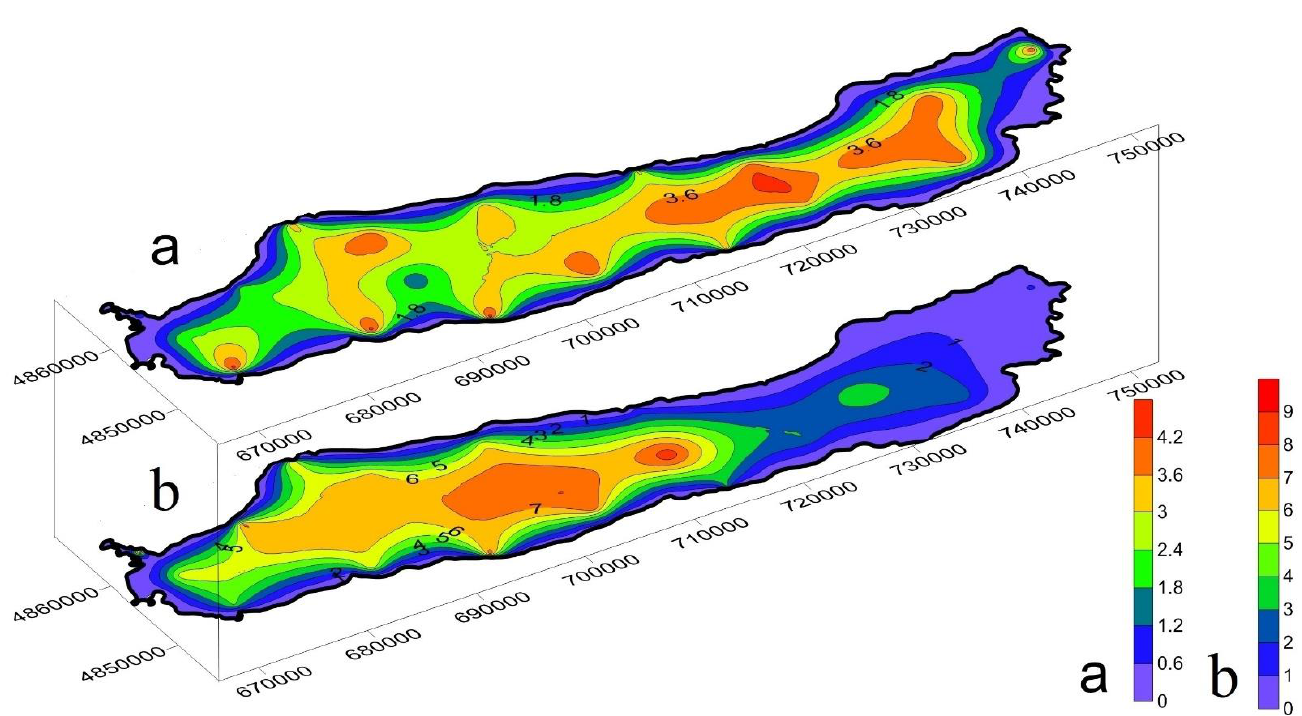
Figure 5. Spatial distribution of lead in water and bottom sediment of the Kapshagay Reservoir. ( a ) Water — µg/L; ( b ) bottom sediment — mg/kg. (authors Ismukhanova L.T., Madibekov A.S.).